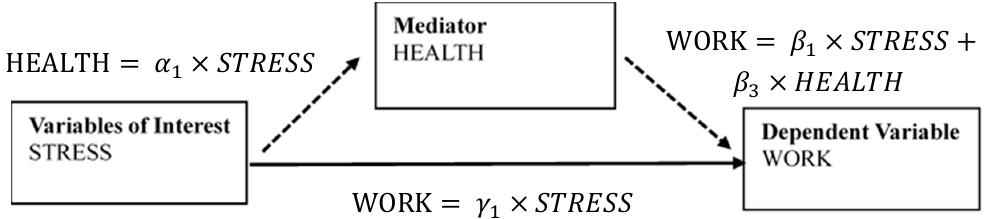
Figure 3. Mediation model design.